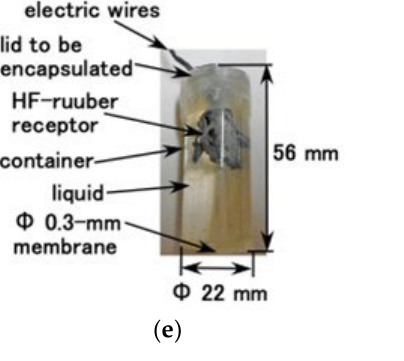
Figure 4. Schematic diagrams and images of fabricated receptors and sensors produced by electrolytic polymerization of HF rubber: ( a ) equivalent electric circuit of free nerve endings; ( b ) equivalent electric circuit of Pacinian corpuscles; ( c ) equilibrium sensor mimicking a saccule; ( d ) auditory sensor with free nerve endings mimicking the organ of Corti; ( e ) auditory sensor with Pacinian corpuscles mimicking the organ of Corti; ( f ) tactile receptors embedded in U-rubber mimicking a finger.